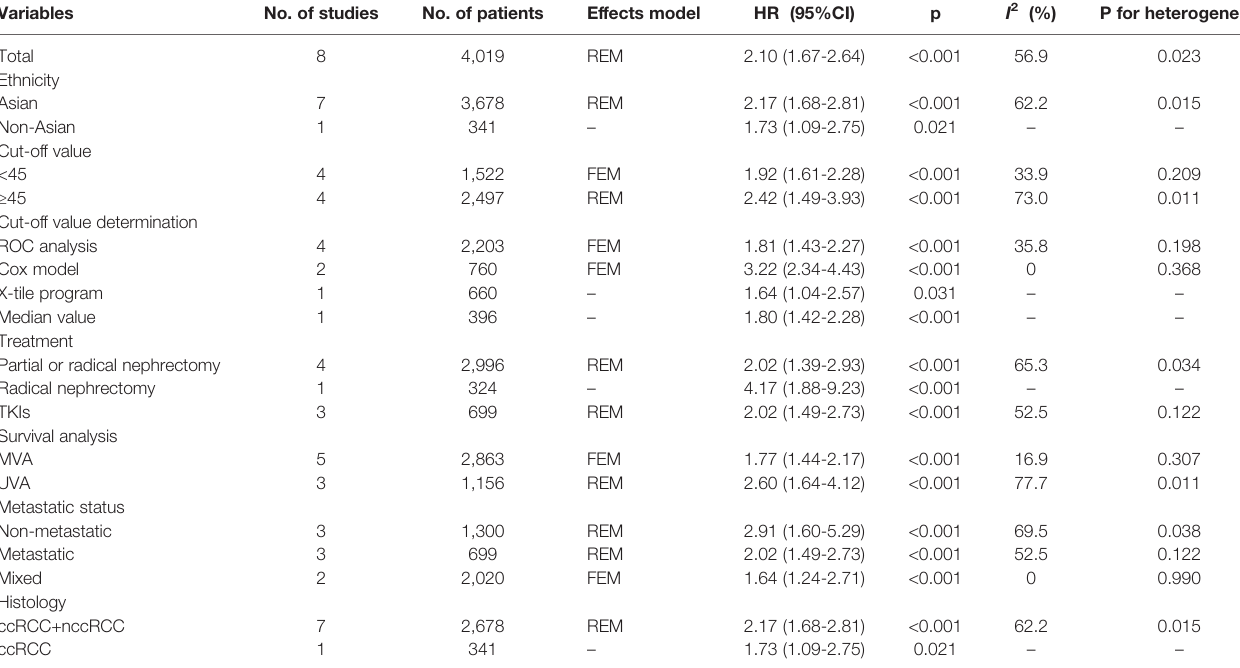
TABLE 3 | Results of subgroup meta-analysis for overall survival.